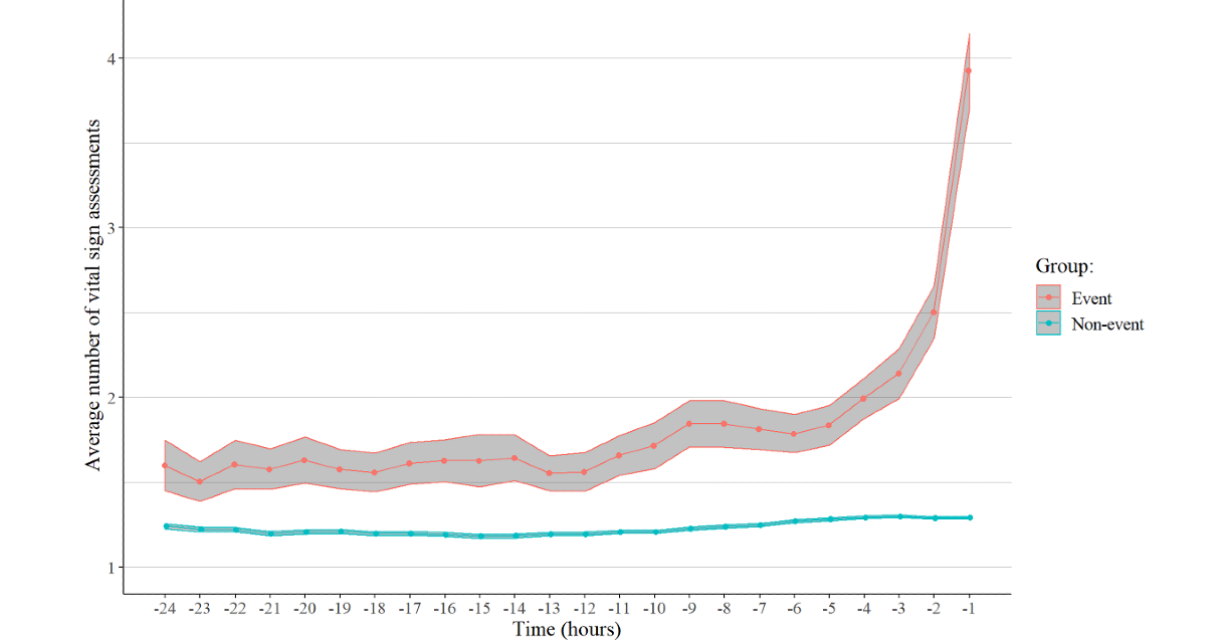
Figure 4. Average numbers of vital sign assessments at each prediction time point for the event and non-event groups. The lines and shaded 95% CIs show the trends for the vital assessments.